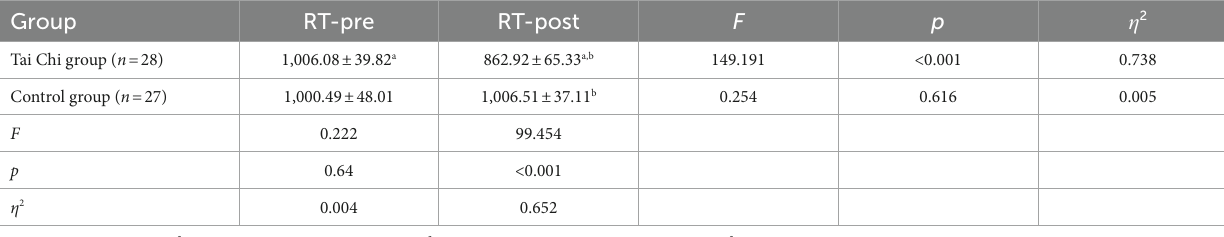
TABLE 3 Results of repeated measures ANOVA c for response time of working memory capability (M ±